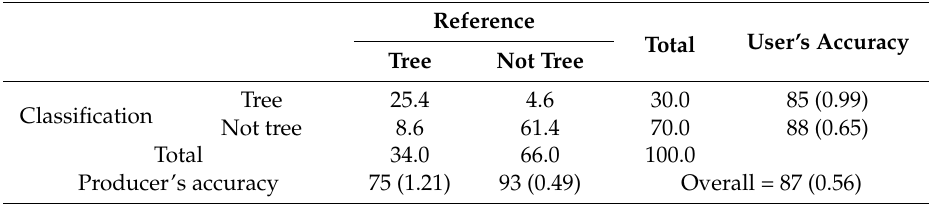
Table 1. Validation matrices for the binary tree cover map using high resolution imagery and airborne lidar validation data. The “tree cover with threshold map” represents the binary classification of the probability surface using manual thresholds, while the “final tree cover map” represents the map after manual editing. As the lidar data was only sampled from the areas of NSW for which it was available it is not representative of the entire state. Also, as the lidar points are clustered the standard errors of the accuracy measures were not